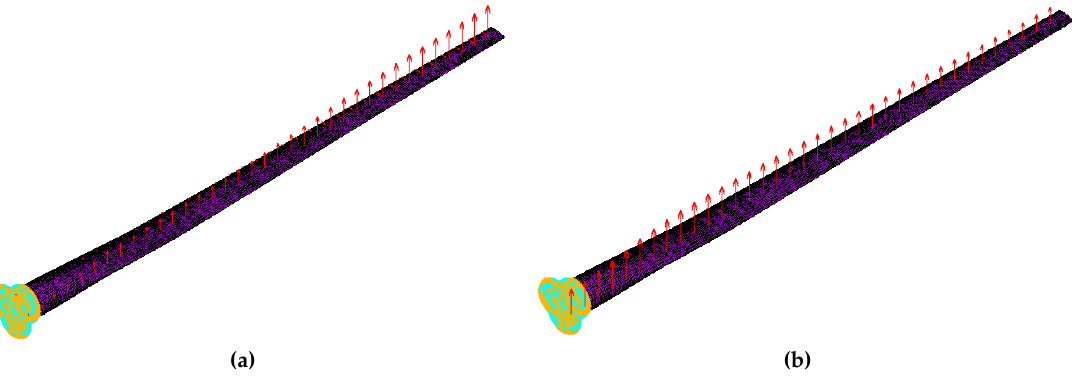
Figure 11. ( a ) Operational load distribution of the FEM model; and ( b ) ultimate load distribution of the FEM model.